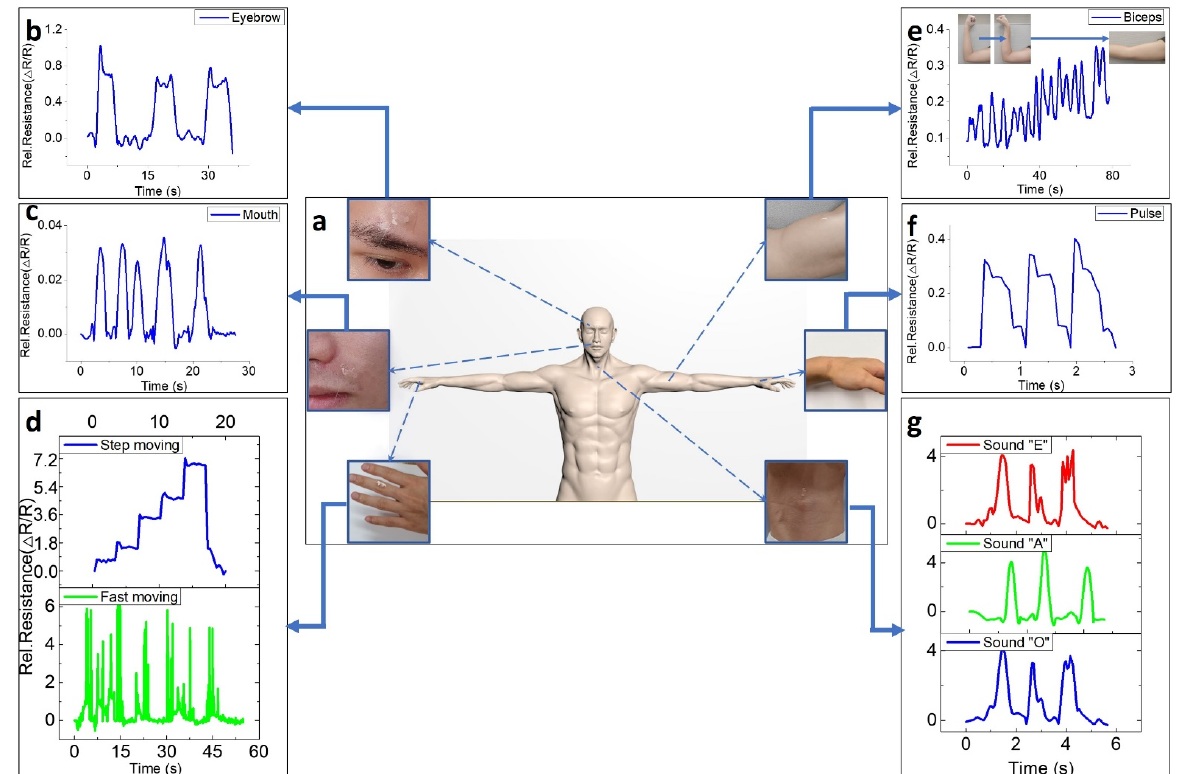
Figure 4. Application of e-skin for wearable devices; ( a ) schematic image of e-skin attached to various parts (eyebrow, mouth, finger, biceps, wrist, vocal cord) of the human body; ( b , c ) response of the e-skin for movement of the eyebrow and mouth to sense facial expression; ( d , e ) response of e-skin for movement of finger and biceps while stepping and moving fast. ( f ) Sensor response of e-skin for pulse. ( g ) Sensing for the sounds “E”, ”A”, and “O” while attached onto throat (vocal cord).